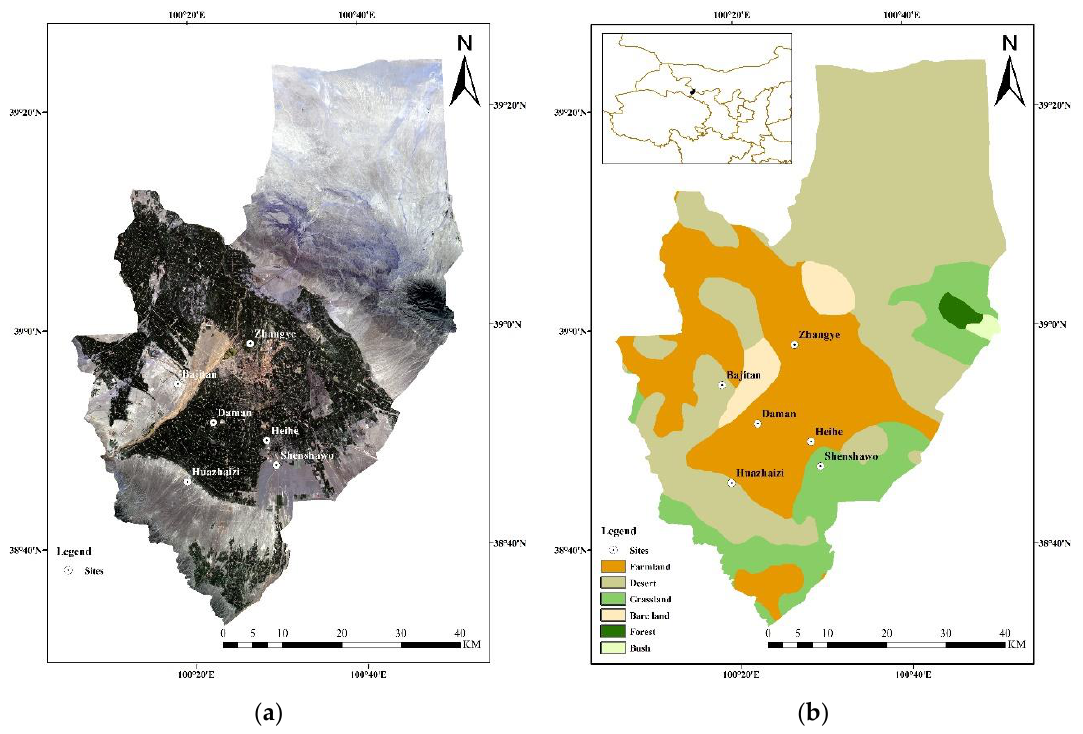
Figure 1. ( a ) Remote sensing image (GF-1 WFV, 17 July 2014) and ( b ) surface classification (GlobeLand30) of Ganzhou District.